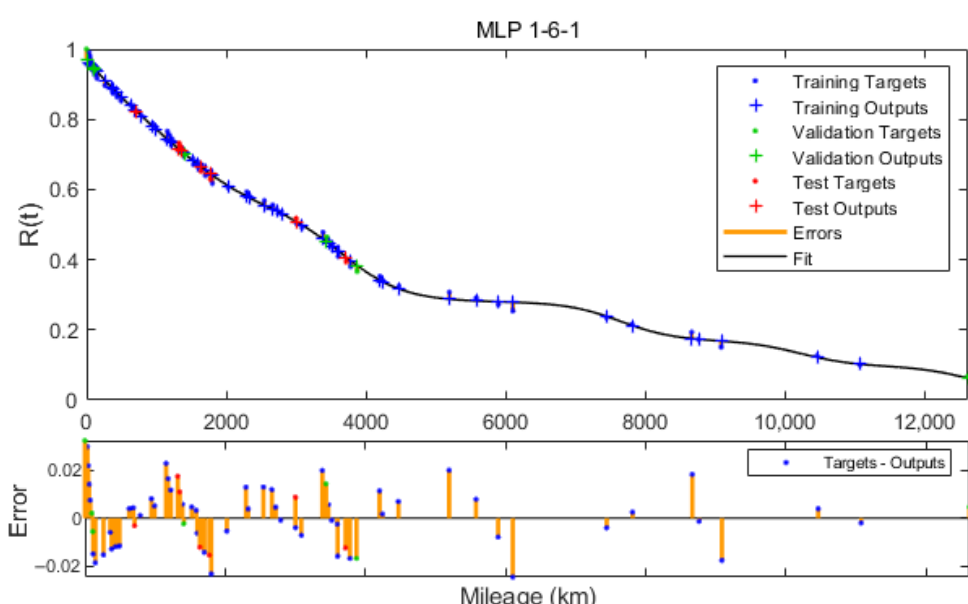
Figure A5. Reliability function approximated by MLP 1-6-1.